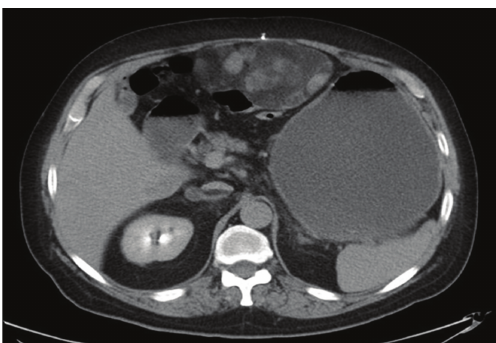
Figure 1: Computed tomographic axial image demonstrating ante- rior epigastric mass and dilated stomach and duodenum.